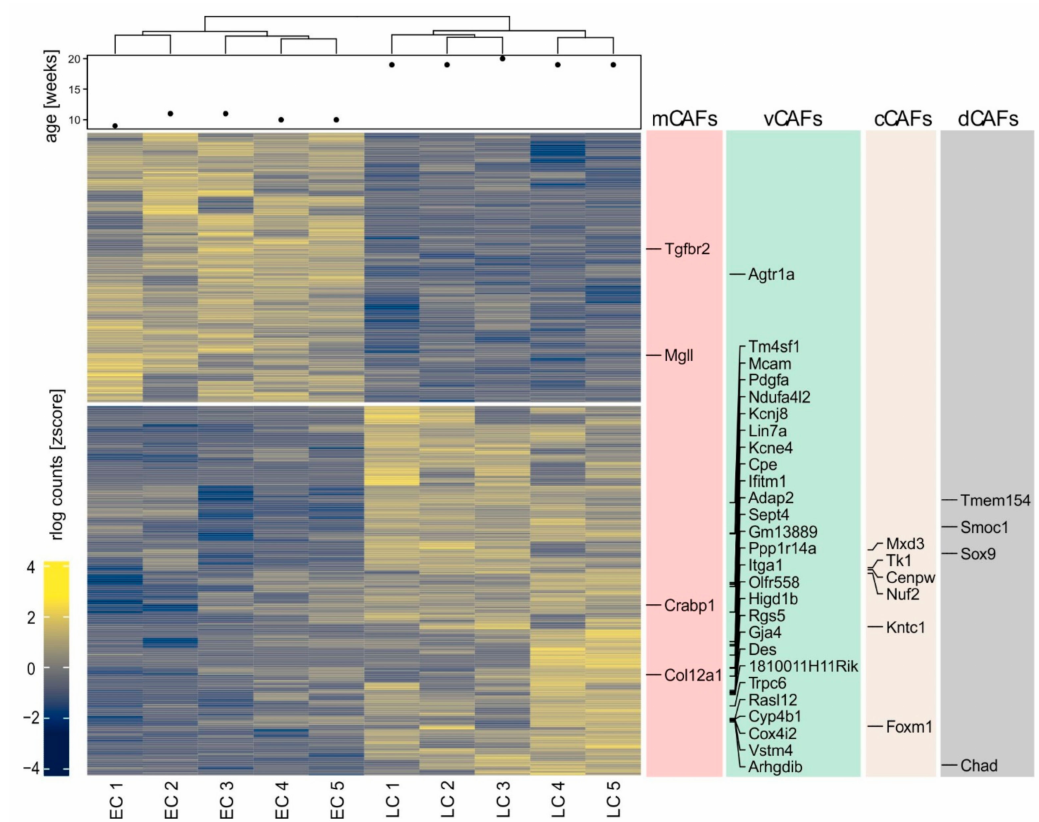
Figure 4. Comparative transcriptome analysis of early- and late-stage PyMT cancer-associated fibroblasts (CAFs). Transcriptomes of FACS-sorted early (EC) and late-stage (LC) PyMT CAFs were generated by mRNA sequencing. The heat map shows di ff erentially expressed genes between both groups. Genes corresponding to individual CAF subsets (matrix CAFs, mCAFs; cycling CAFs, cCAFs; vascular CAFs, vCAFs; and developmental CAFs, dCAFs) are